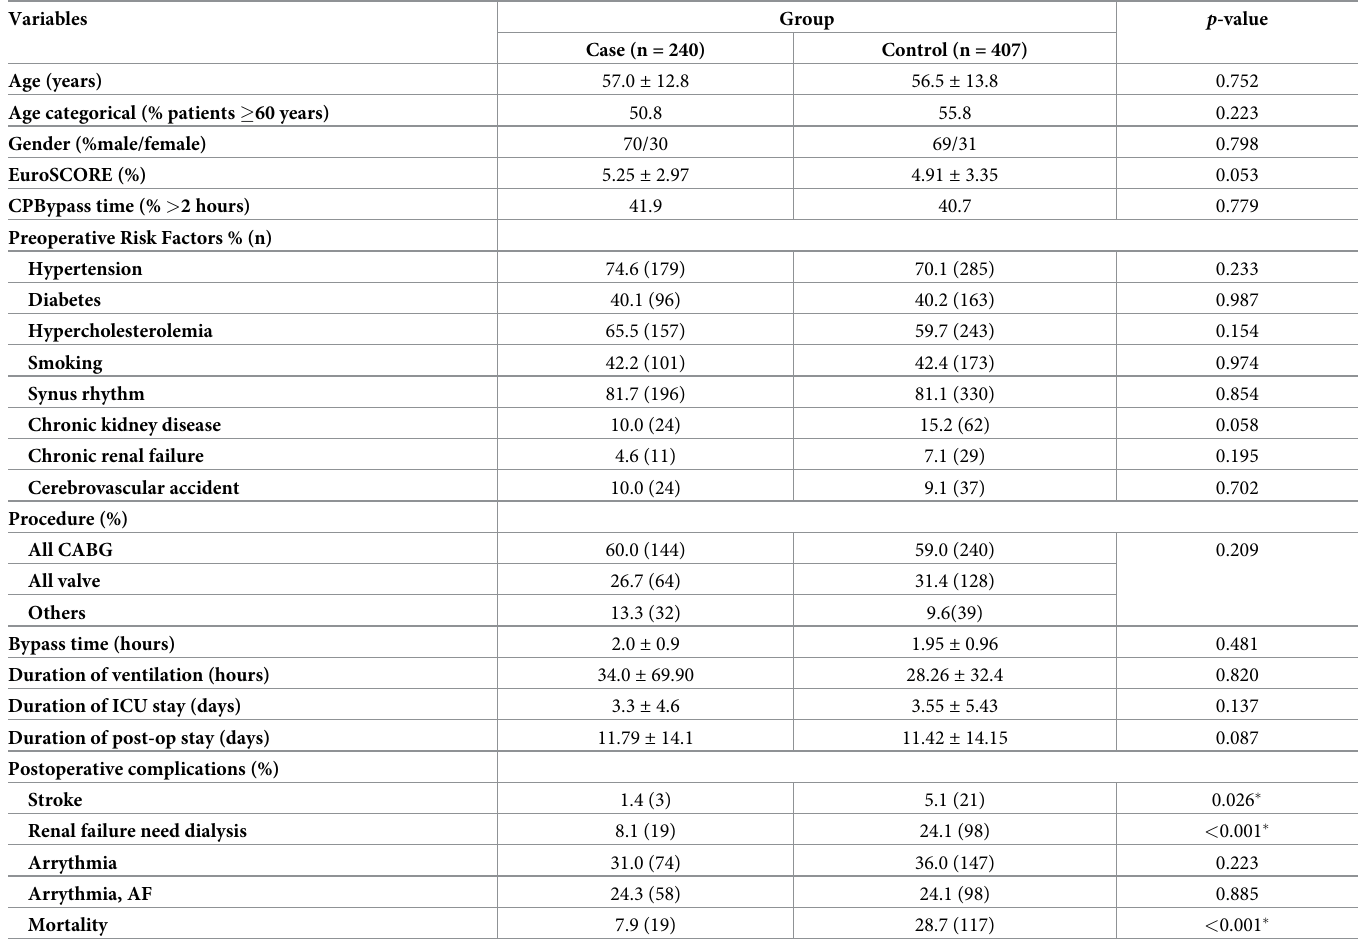
Table 1. Demographic profiles, risk factors and postoperative complications of the case and control